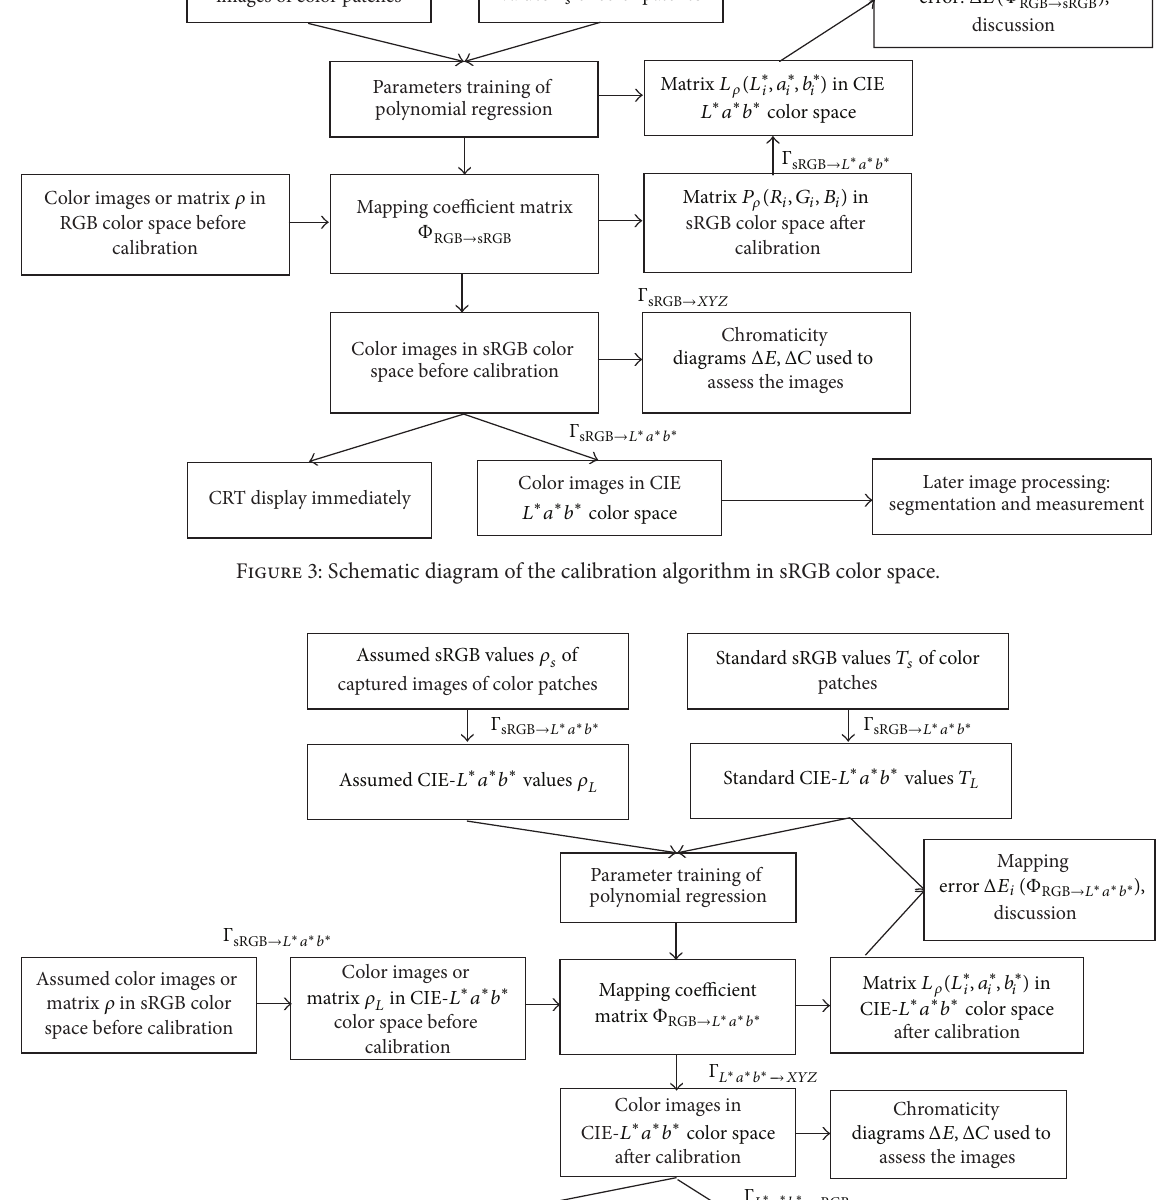
from Φ RGB → sRGB and Φ RGB →𝐿 ∗ 𝑎 ∗ 𝑏 ∗ are still higher than that of 11 terms. When ( 𝑅 𝐺 𝐵 1 ) are used for